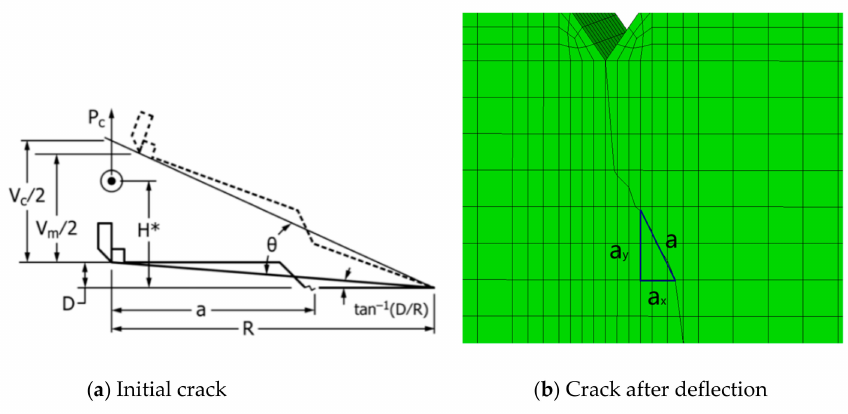
Figure 5. Crack rotation angle, θ , of the compact tension (CT) specimens. ( a ) Initial crack; ( b ) Crack after